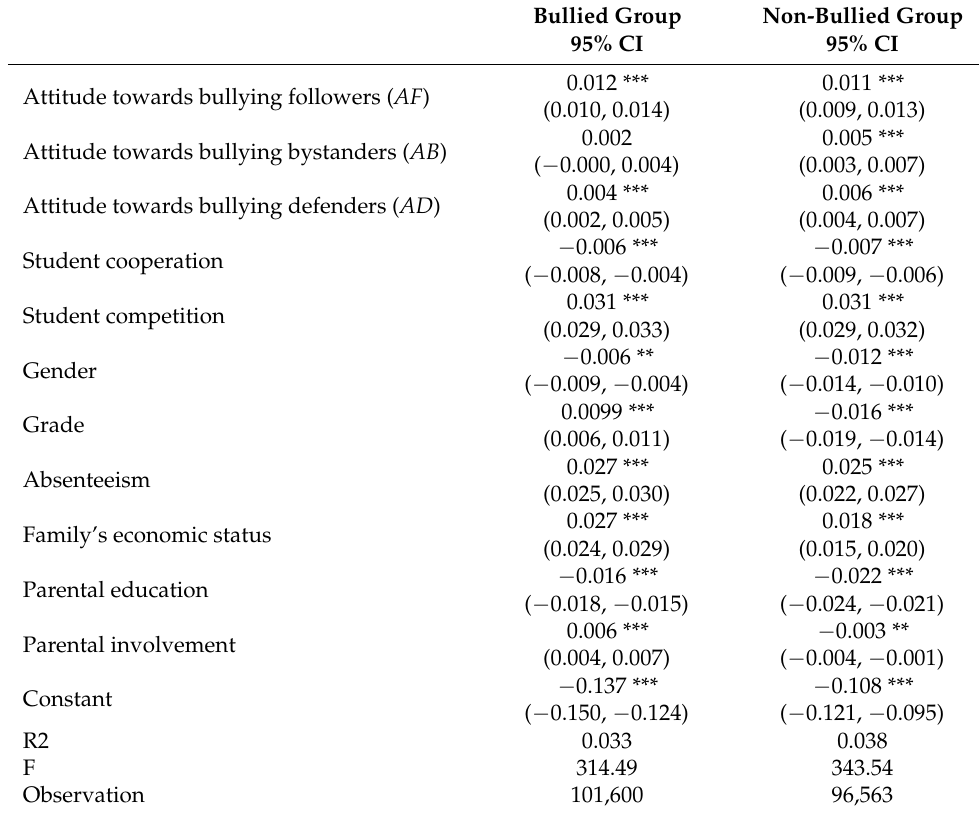
Table 4. Differences in adolescent bullying attitudes after matching, by gender and grade.